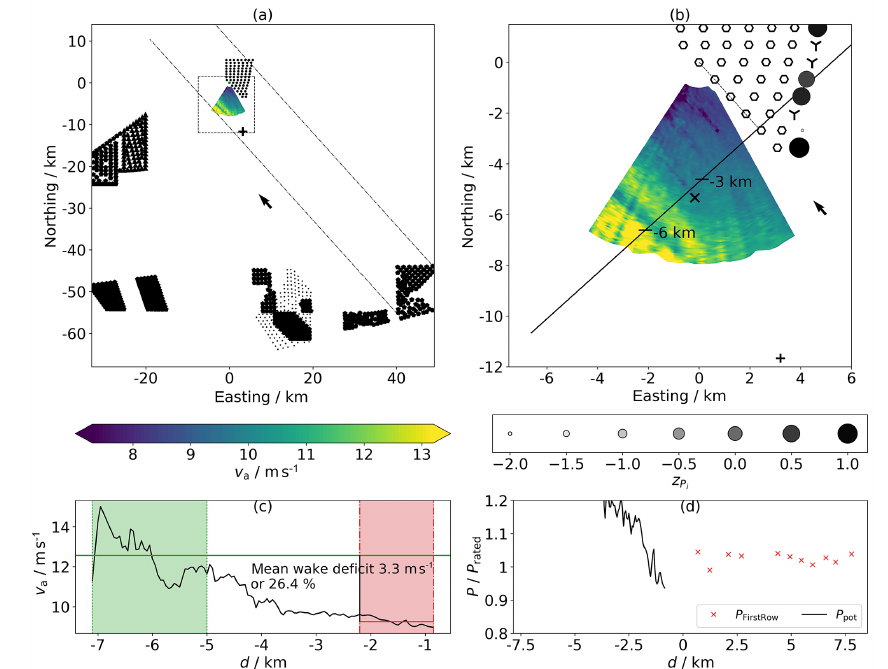
Figure 10. Lidar measurement (scenario A) of the wake of the DolWin2 cluster on 11 October 2018 17:16–17:20UTC; power data of upstream turbines 17:10–17:20UTC, as in Fig. 6. Downstream turbine positions marked (hexagon). Turbine numbers to calculate the z score are 8, 15, 22, 29, 36, 43, 50, 68, 72, 78, and 80. Additionally, we marked the converter platform BorWin gamma ( + ).